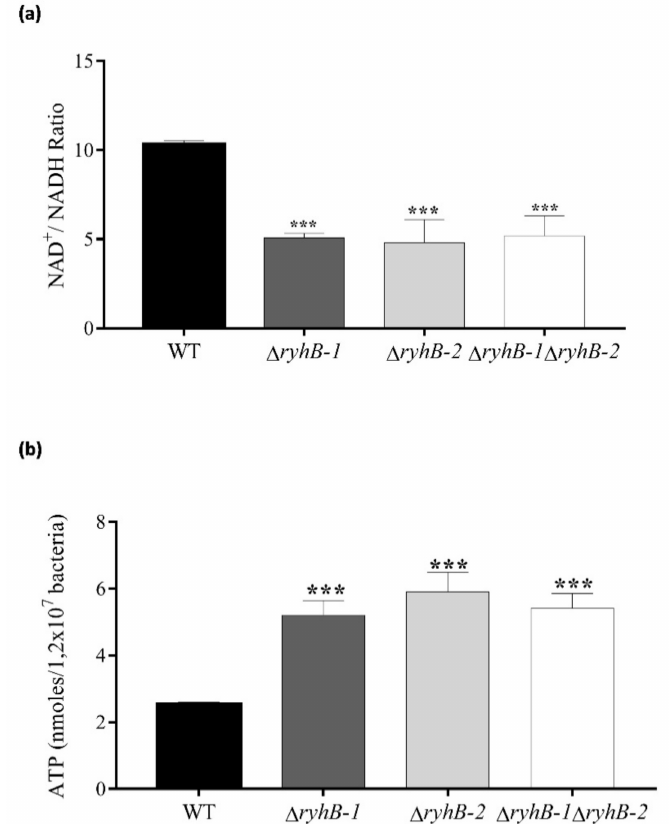
Figure 2. Metabolic status of intracellular S. Typhimurium ryhB s mutants. RAW264.7 macrophages were infected with wild type (WT), ∆ ryhB-1 , ∆ ryhB-2 , and ∆ ryhB-1 ∆ ryhB-2 strains, and both the NAD + /NADH ratio ( a ) and ATP levels ( b ) were determined from intracellular bacteria at 8 hpi. Asterisks represent statistical differences with respect to the wild type strain (*** p = 0.0001). Data represent the means ± standard deviations ( n =